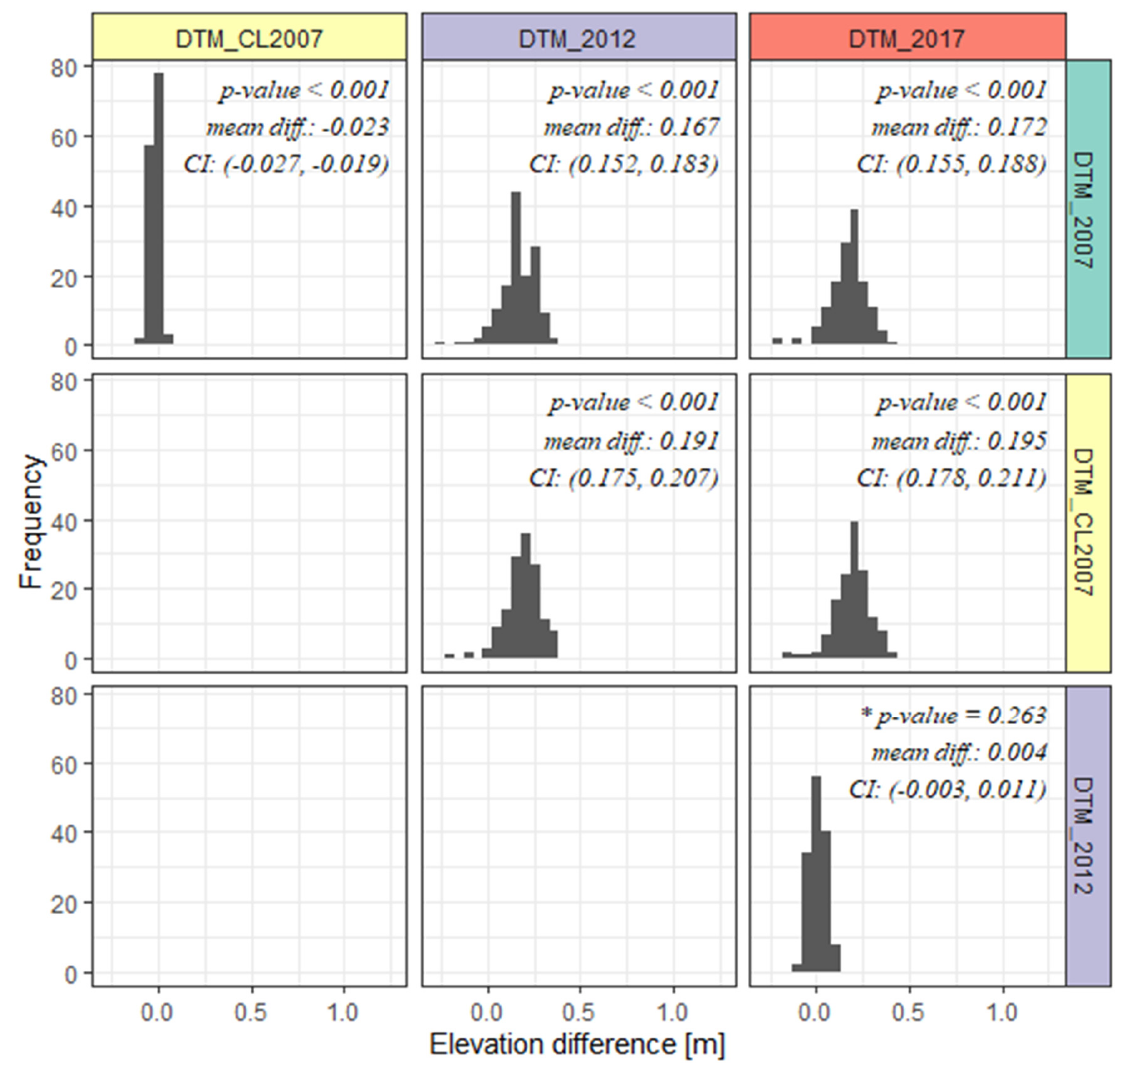
Figure 7. Comparison of distributions of mean elevation differences on smoothed terrain models generated based on 2007, 2012, and 2017 ALS data. * statistically significant.